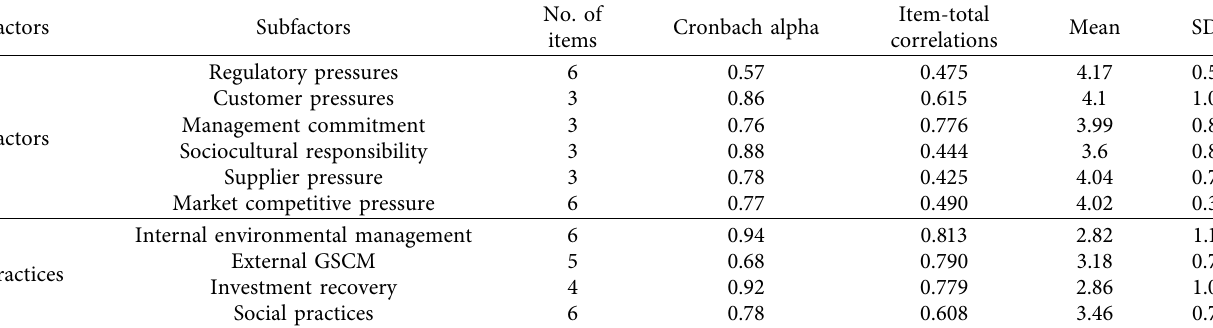
Table 7: Descriptive statistics and Cronbach alpha values.